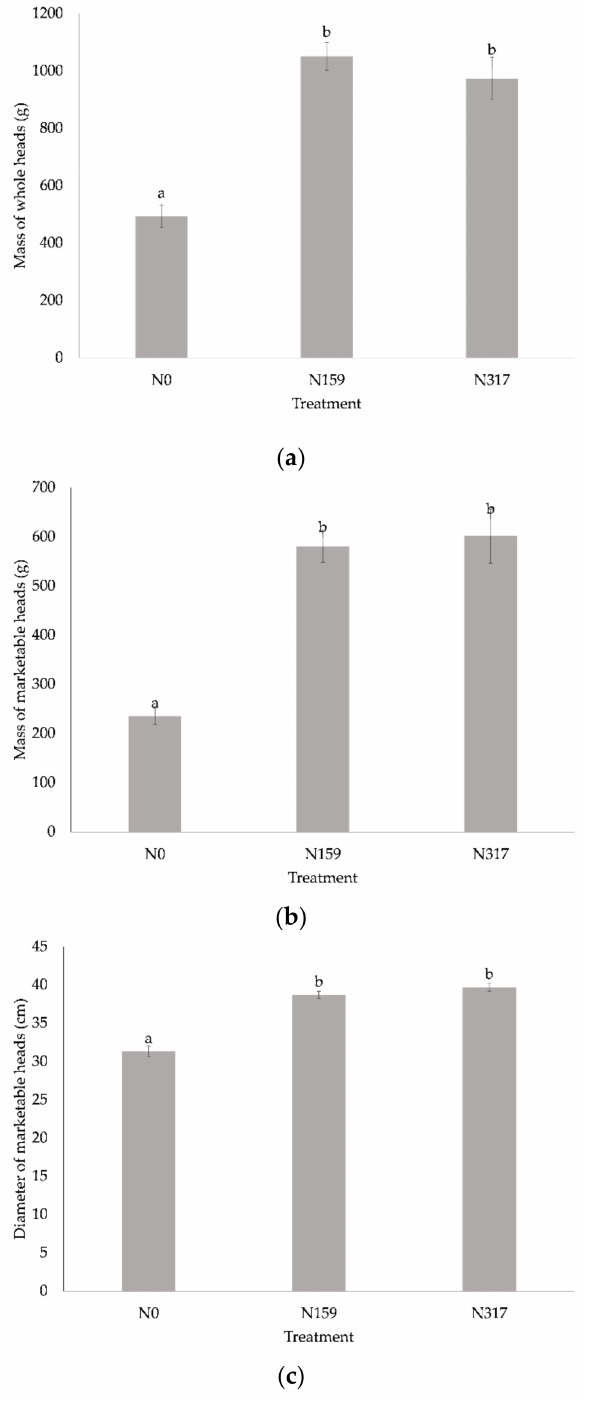
Figure 3. The ( a ) mass of whole heads (g), ( b ) mass of marketable heads (g), and ( c ) diameter of marketable heads (cm) (mean ± SE); a and b lower case letters denote statistical significant differences ( α < 0.05) among